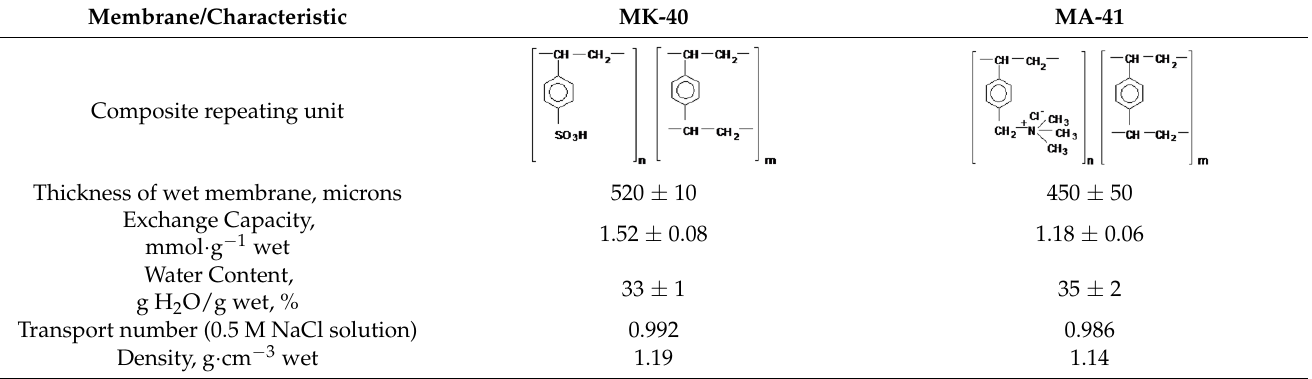
Table 2. Physical-chemical characteristics of the ion-exchange membranes used [44].